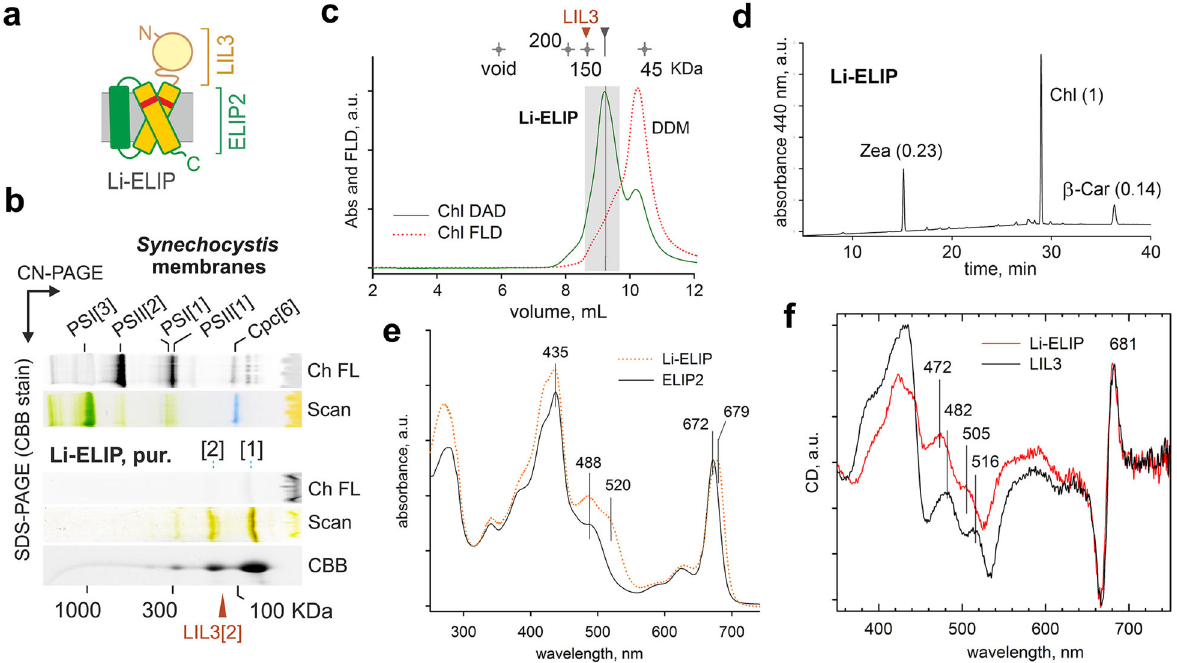
Fig. 2 Characterization of the isolated Li-ELIP protein. a A scheme of chimeric Li-ELIP protein; see also Supplementary Fig. 1 for the protein amino acid sequence. b Synechocystis membranes and the puri fi ed Li-ELIP were separated on CN-PAGE, 5 and 1.4 μ g of Chl were loaded, respectively. The gel was scanned (Scan) and Chl fl uorescence (Ch FL) was detected after excitation with blue light. Proteins were further separated by SDS-PAGE in the second dimension and the 2D gel was stained with Coomassie Blue (CBB). c SEC separation of Li-ELIP; Chl absorbance and fl uorescence were monitored during chromatography by diode-array and fl uorescence detectors (Chl DAD and Chl FLD). Fractions of 0.5 mL were collected, and those shown within the grey rectangle were concentrated and used for pigment analysis. d Extracted pigments were analysed by HPLC; molar stoichiometries of the identi fi ed pigments are shown in parentheses. Values represent means of three technical replicates; standard deviations were below 10%. e Absorption spectra of Li-ELIP and ELIP2 proteins as recorded by a DAD during SEC. f CD spectra in the visible region of LIL3 and Li-ELIP proteins. Data were scaled to the CD of the Q y region at 660 – 690